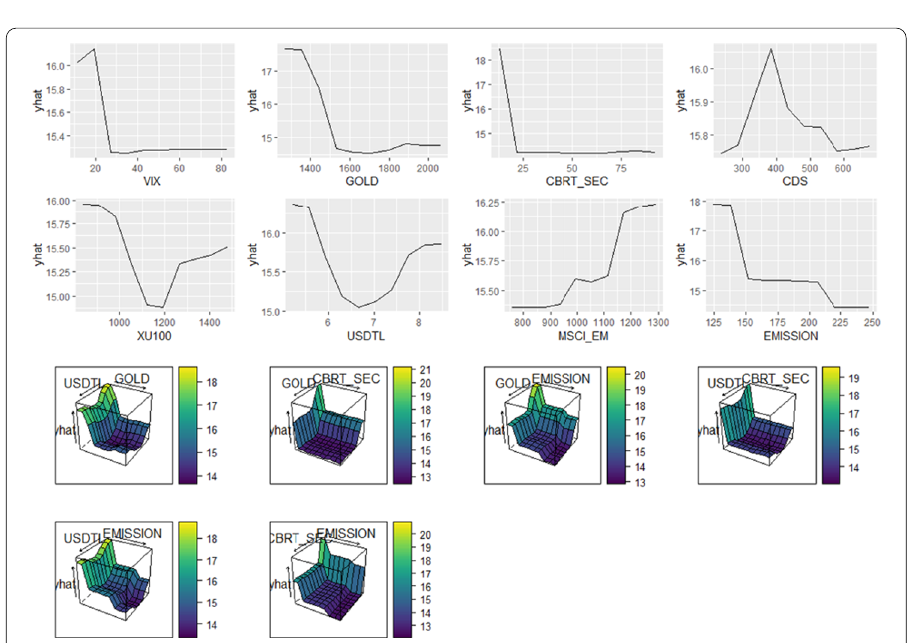
Fig. 6 Thresholds of the independent determinants by